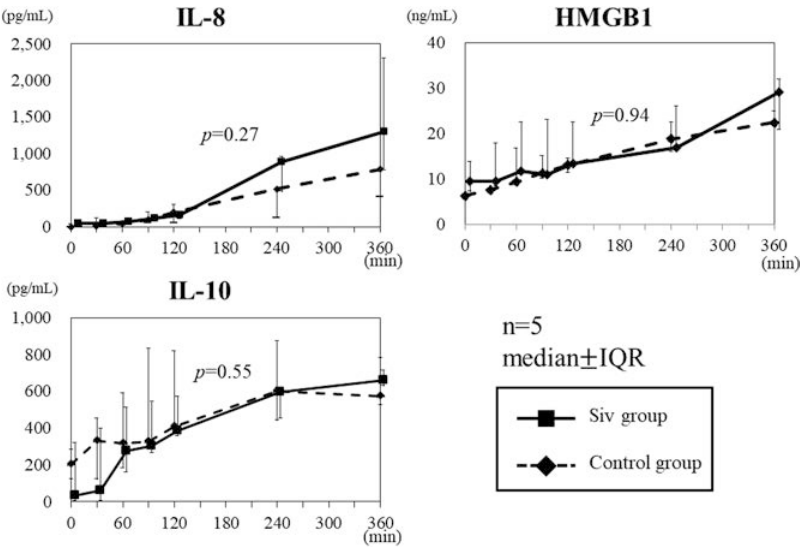
Figure 5 IL-8, HMGB1, and IL-10 levels in the Siv treatment and control groups. IL-8, HMGB1, and IL-10 levels tended to increase over time in both the Siv treatment and control groups. The difference in these levels between the Siv treatment and control groups was not significant. IQR: interquartile range; Siv: sivelestat sodium